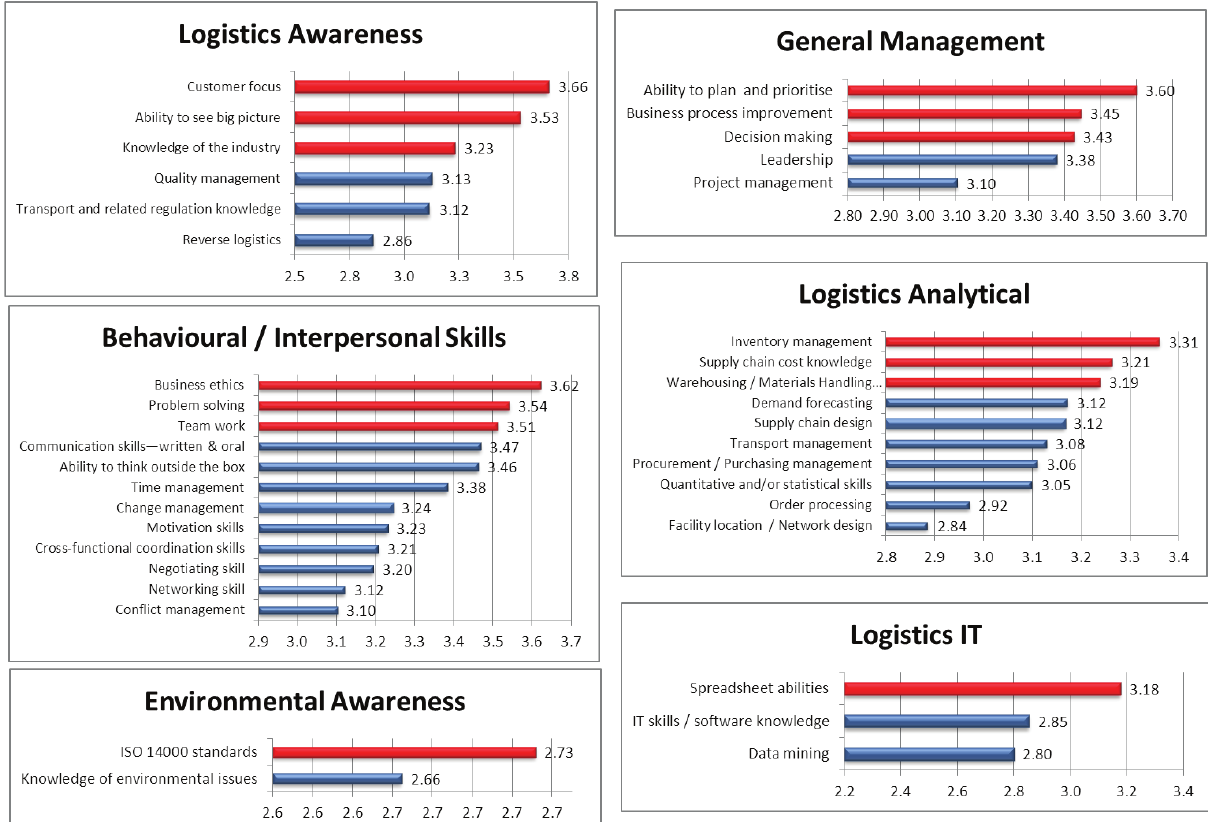
Figure 4: Ranking of skills per skills